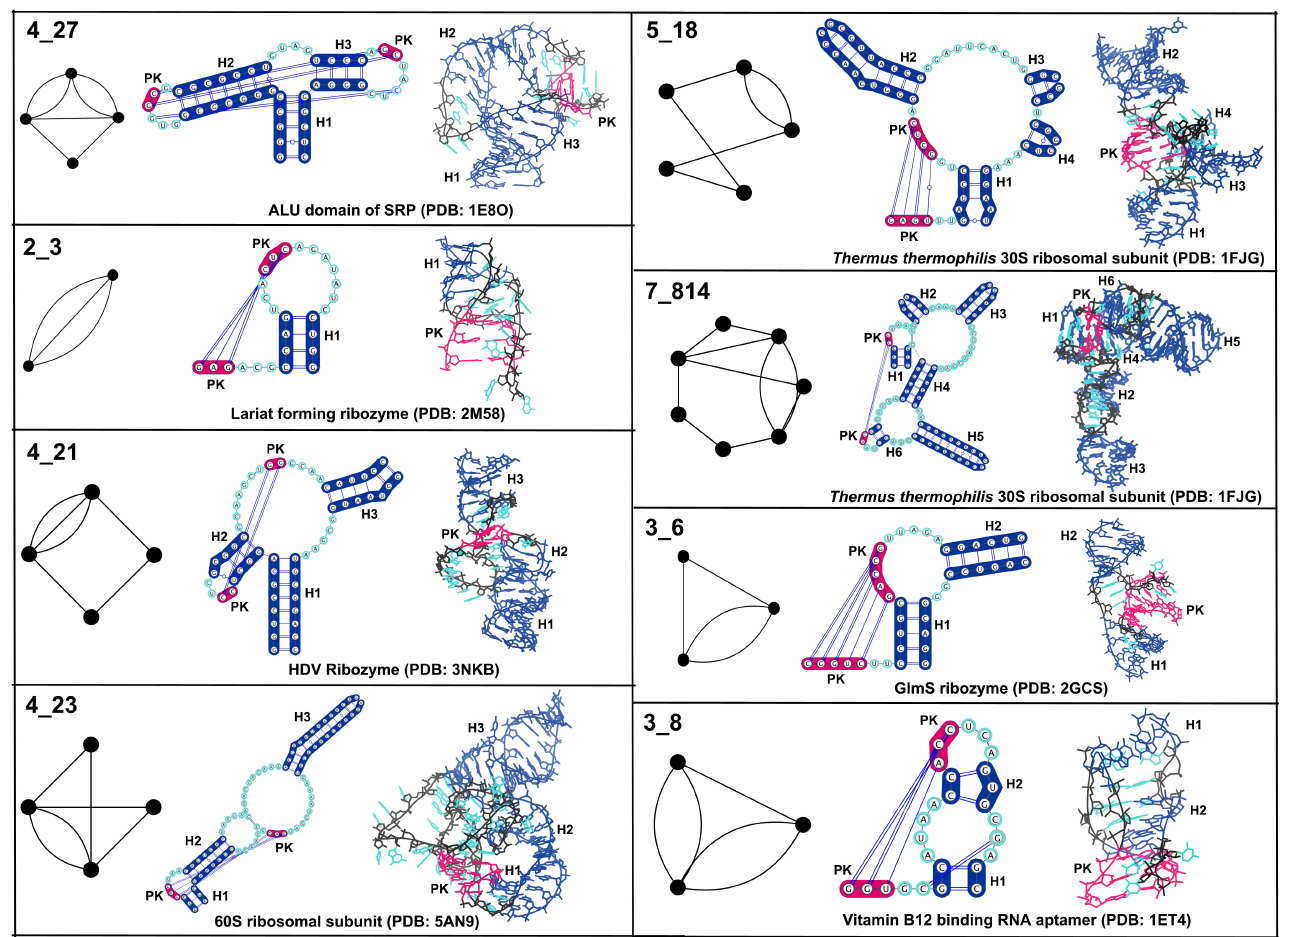
Figure 6. Common subgraph blocks with pseudoknots. Shown for each dual graph block topology with 10 or more occurrences (found by partitioning dual graphs in the representative RNA dataset) are the 2D and 3D structure fragments of one representative example. The same colors in the 2D and 3D structures correspond to similar regions. Pseudoknots are marked as PK and are shown in magenta. Standard helices are marked as Hi , where i indicates the helix